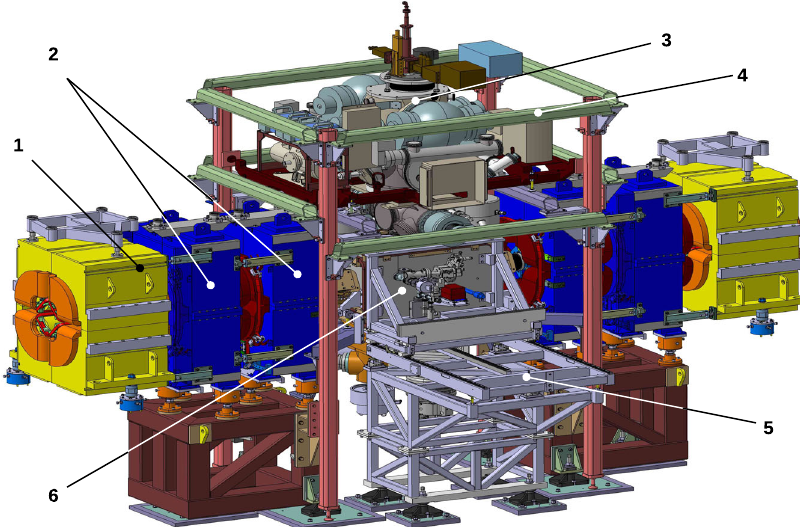
FIG. 4. View of the PAX installation at COSY from the interior of the ring (the beam comes from the left). 1: COSY quadrupole magnet; 2: two of the four PAX quadrupoles (formerly used at CELSIUS [48]) forming the low- β insertion by doublet focusing (DF-FD); 3: atomic beam source (ABS); 4: support system; 5: flange supporting rail system; 6: PAX target chamber housing the storage cell. The Breit-Rabi polarimeter (BRP) and the target-gas analyzer (TGA) are mounted towards the outside of the ring. The horizontal distance between the inner faces of the two COSY quadrupole magnets is 3.75 m, the height of the beam-tube center from the ground is 1.80